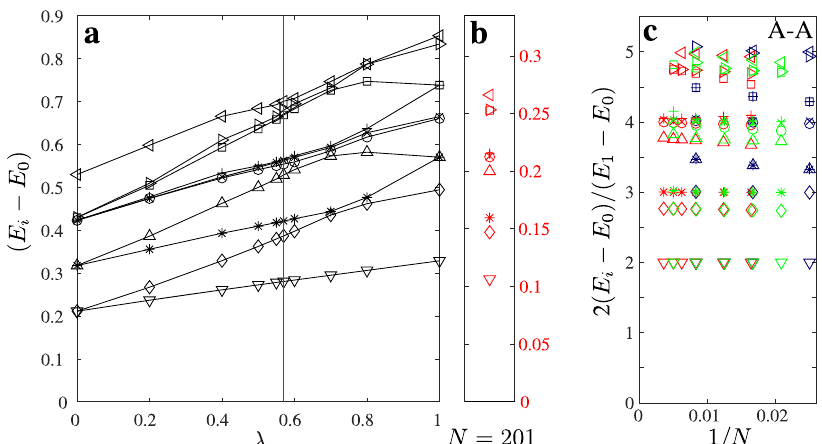
Fig. 8 Identi fi cation of the Ashkin – Teller parameter λ from the conformal tower of states. a Excitation spectrum of the Ashkin – Teller model as a function of λ for N = 60 and A − A boundary conditions (black). Reg line indicate the point where the Ashkin – Teller spectrum resembles the structure presented in b . b Excitation spectrum of the hard-boson model with N = 201 sites (red). c Conformal towers of states for hard-boson (red), Ashkin – Teller at λ = 0.57 (green), and four-state Potts as Ashkin – Teller with λ = 1 (blue). The tower is plotted with respect to the lowest excitation energy.